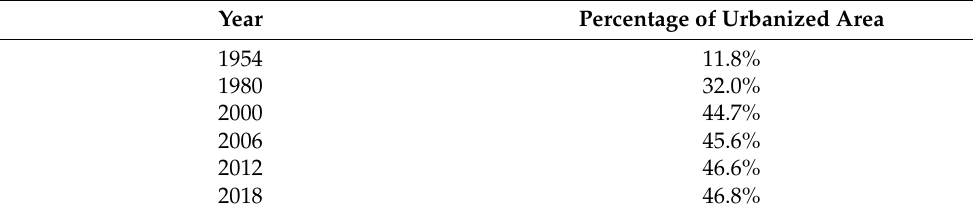
Figure 2. CN values for the years 1954, 1980, 2000, 2006, 2012 and 2018 for the Seveso River catchment closed at Bovisio-Masciago town; the geographical reference system is Roma 1940 Gauss Boaga Ovest. Table 1. Percentage of urbanized area over the Seveso River basin closed at the Bovisio-Masciago gauge section.